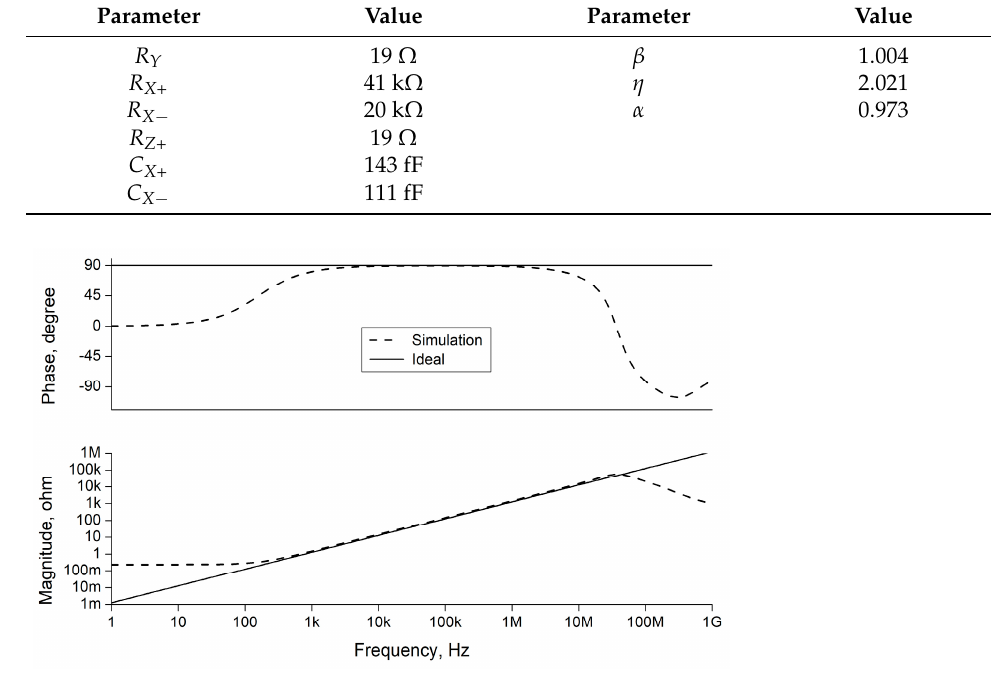
Figure 6. Frequency responses of the proposed simulated inductor and ideal inductor.